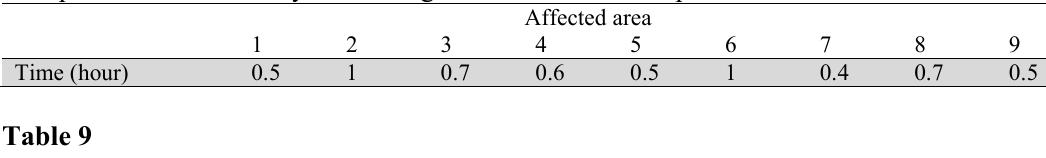
International suppliers’ capacities for relief commodities Suppliers